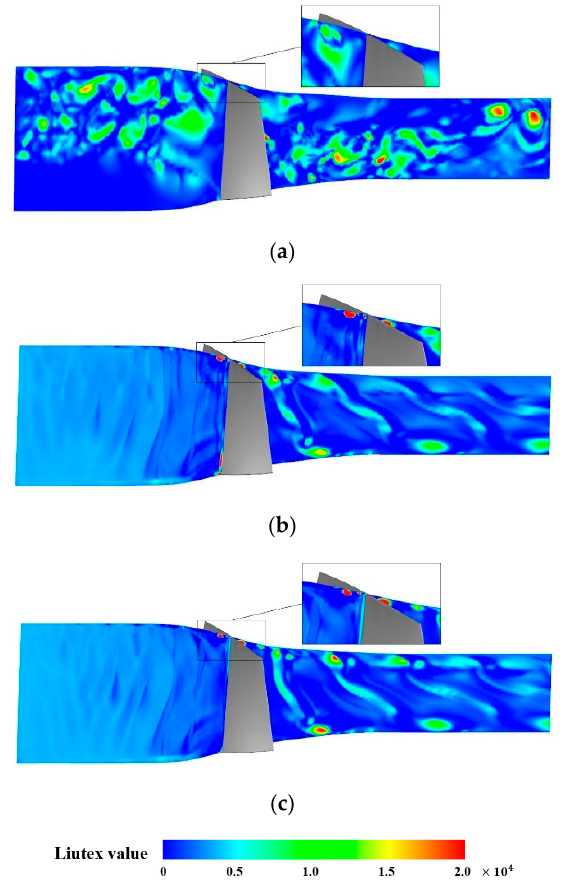
Figure 11. Liutex value character in the NASA rotor 37 at ( a ) NS condition, ( b ) design condition, ( c ) NC condition.